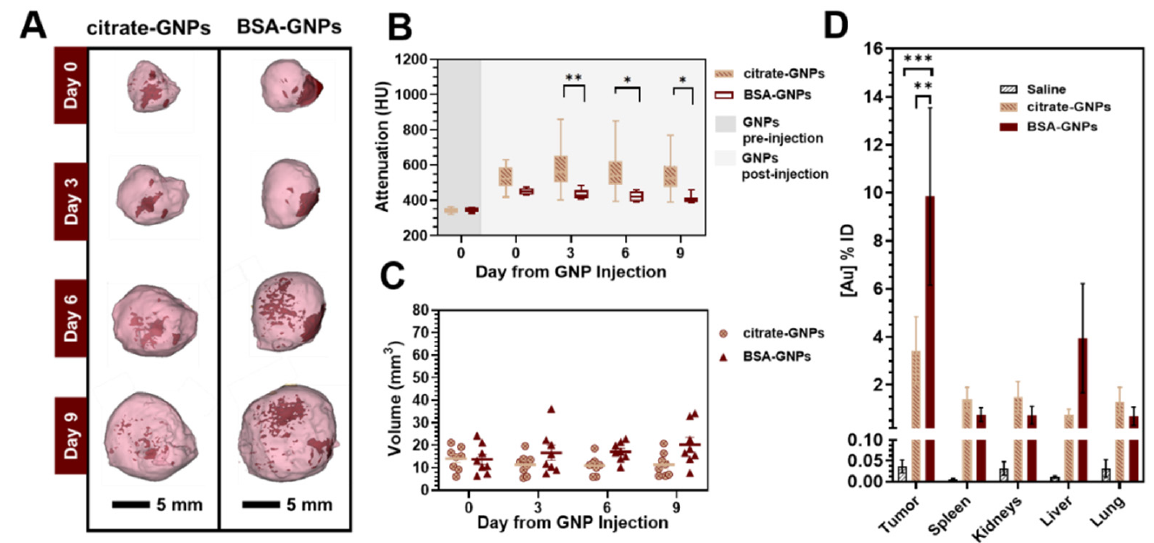
Figure 5. Micro-CT and ICP-OES results both confirm that particles remain in the tumor 9 days post-injection. ( A ) Representative 3D volume renderings of micro-CT images of concentrated GNPs manually intratumorally injected into solid LLC-Luc tumors grown on the right flanks of C57BL/6 mice (9 days follow up). Images are rendered at a window level of 1090 HU with 930 HU window width. With this color look-up table, solid tumors are shown in pink (40% transparency) and contrast arising from the injected GNPs is shown in dark red (GNP clusters). Images are displayed with a voxel size of 100 µ m. ( B ) Mean attenuation values in Hounsfield units (HU) calculated within the GNP cluster volume over time using CT follow-up images. Significant difference in BSA-GNPs vs. saline group and citrate-GNPs over time (* p < 0.05, ** p < 0.005 Tukey’s multiple comparisons test). ( C ) GNP cluster volume over time calculated using CT follow-up images. ( D ) Biodistribution of citrate- GNPs and BSA-GNPs in digested organs 9 days post-injection ( n = 8 mice per group) using ICP- OES. Saline injections were performed on 4 mice as a negative control group (black bars). A two- way ANOVA test was done to compare the interactions between each group. Significant difference of BSA-GNPs vs. saline group and citrate-GNPs (** p < 0.005, *** p < 0.0005 Tukey’s multiple com- parisons test).